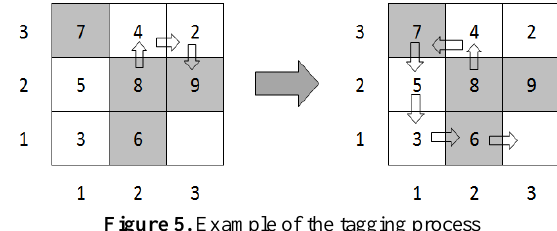
Figure 5. Example of the tagging